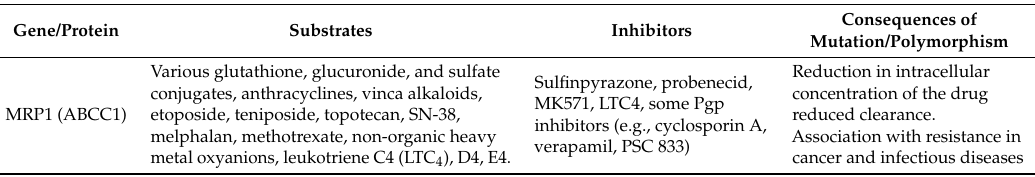
Table 1. The pharmacological substrates and inhibitors of multidrug resistance-associated proteins (MRP) 1 and 2 mediating drug resistance